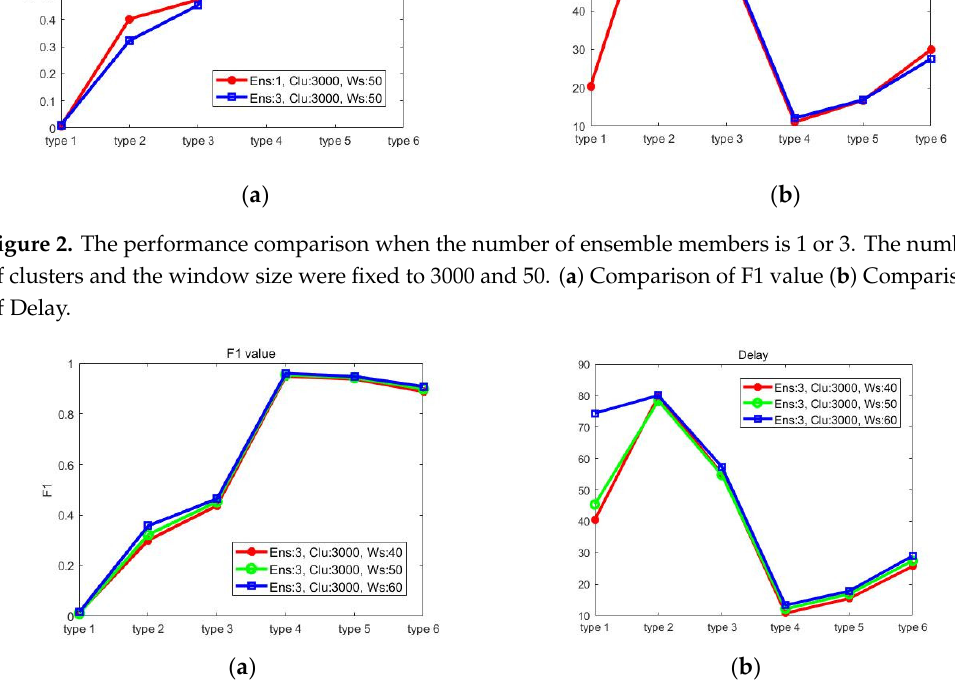
Figure 3. The performance comparison when the window size is set to 40, 50, 60. The number of ensemble members and clusters were fixed to 3 and 3000. ( a ) Comparison of F1 value ( b ) Comparison of Delay.